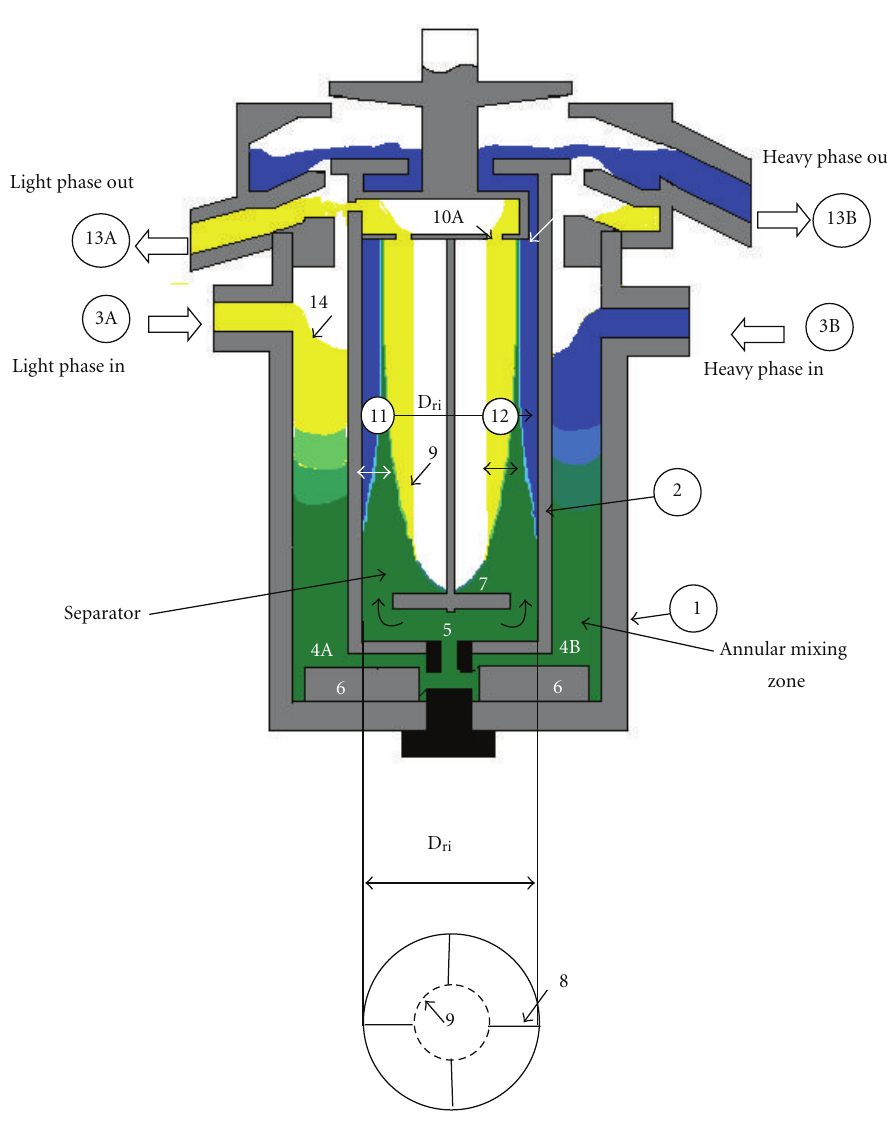
Figure 1: Schematic diagram of the annular centrifugal extractor (ACE) [6] (1) stationary cylinder, (2) rotating cylinder, (3A) light-phase inlet, (3B) heavy-phase inlet, (4A and B) Region below rotating cylinder, (5) central opening for rotating cylinder, (6) radial ba ffl es on the stationary bottom plate, (7) deflecting ba ffl e in the rotor, (8) vertical ba ffl es in the rotor, (9) interface between air and light phase, (10A and B) overflow weirs for lighter and heavier phase, respectively, (11) clean width for heavy phase, (12) clean width for light phase, (13A and B) Outlets for light and heavy phases, respectively, (14) liquid level in the